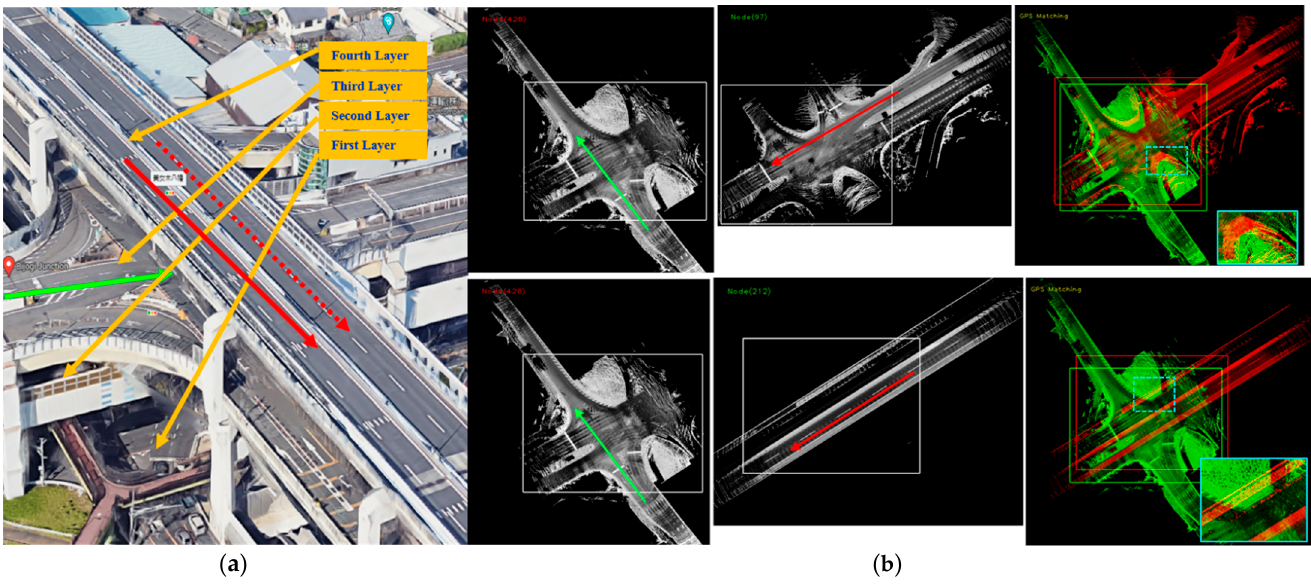
Figure 15. GIR map inconsistency at Bijogi Junction in the same global area in XY plane. ( a ) Road structure in Bijogi Junction consisting of four layers of a plus shape. ( b ) First row: relative position error between two nodes at the third layer that were scanned in different driving directions. Second row: GIR map inconsistency between third and fourth layers at the same global area in the XY plane showing the misalignment of the road structure.